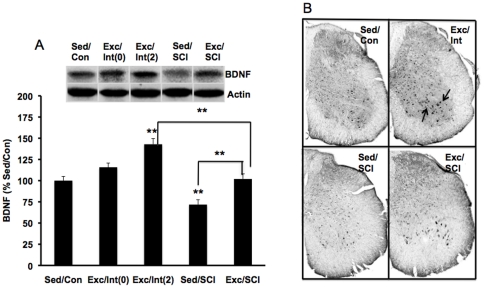
Effects of SCI and exercise on BDNF levels in the lumbar region of the spinal cord.(A) Exercise elevated levels of BDNF in intact animals sacrificed on the last day of exercise (Exc/Int(0)) or two days after ceasing exercise (Exc/Int(2)). SCI reduced levels of BDNF while exercise counteracted these effects (Exc/SCI). Representative western blot bands displaying BDNF are shown for each animal group. **P<0.01. (B)Microphotographs of representative immunohistochemical sections showing localization of BDNF in the hippocampus. SCI reduced BDNF immunolabeling (Sed/SCI) mainly affecting motoneurons (white arrows), but exercise prior to the SCI prevented these effects (black arrows; Exc/SCI).